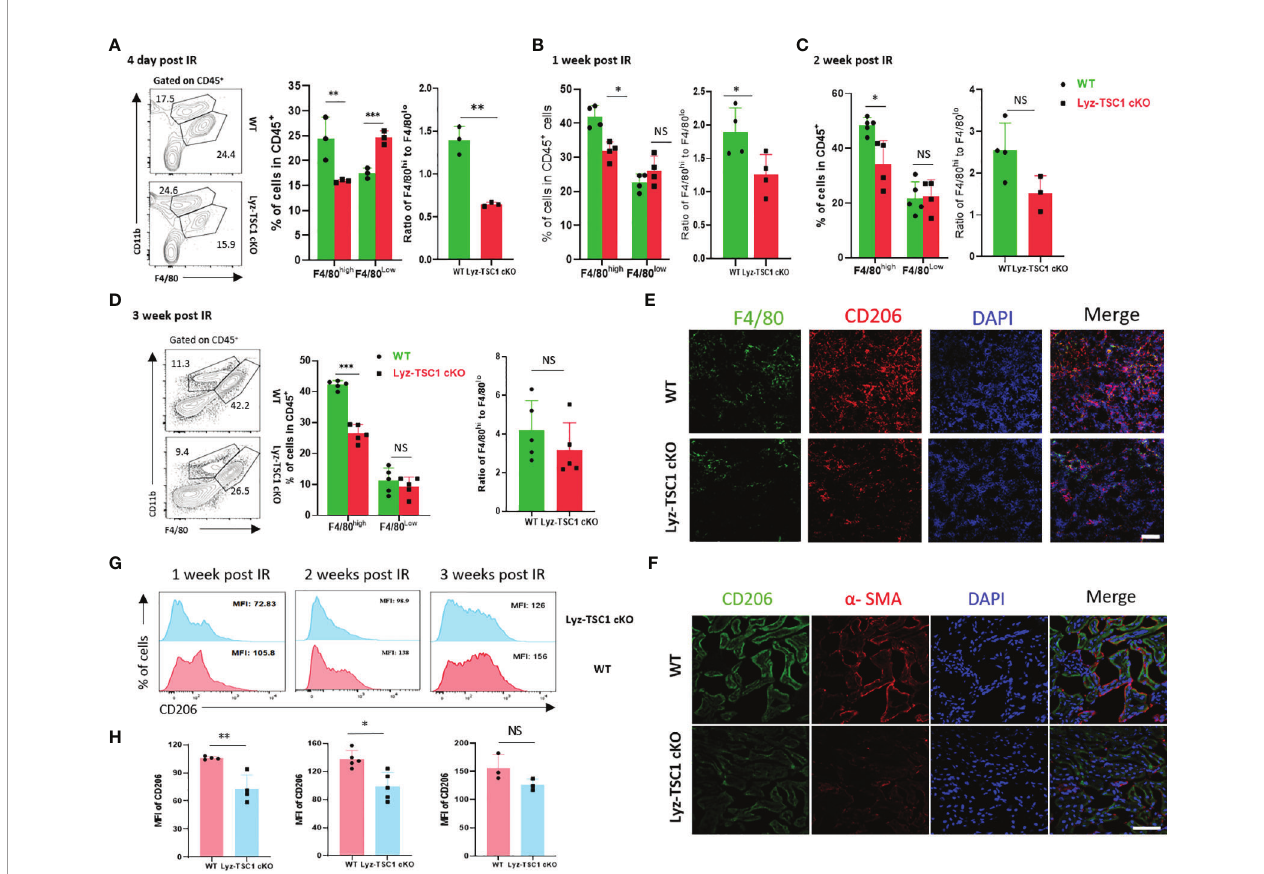
FIGURE 4 | Decreased M2 polarization in Lyz-TSC1 cKO macrophages during the repair process of renal ischemia-reperfusion. (A – D) Left panel: representative dot plots of the proportion of F4/80 hi and F4/80 low macrophage subsets in CD45 + cells in the WT and Lyz-TSC1 cKO kidneys. Middle panel: quanti fi cation of the proportion of F4/80 hi and F4/80 low macrophage subsets in CD45 + cells. Right panel: ratio of F4/80 hi and F4/80 low macrophage subsets. (A) Day 4 post-IRI. (B) Day 7 post-IRI. (C) Day 14 post-IRI. (D) Day 21 post-IRI. (E) M2 macrophages were double-positive for F4/80 (green) and CD206 (red) by immuno fl uorescence in the WT and Lyz-TSC1 cKO kidneys on day 14. Scale bar: 50 µm. (F) Kidney sections were subjected to immuno fl uorescence staining for CD206 and a-SMA. Scale bar: 50 µm. (G, H) CD206 mean fl uorescence intensity (MFI) in macrophages in WT and Lyz-TSC1 cKO mice kidney were analyzed after ischemia-reperfusion injury on